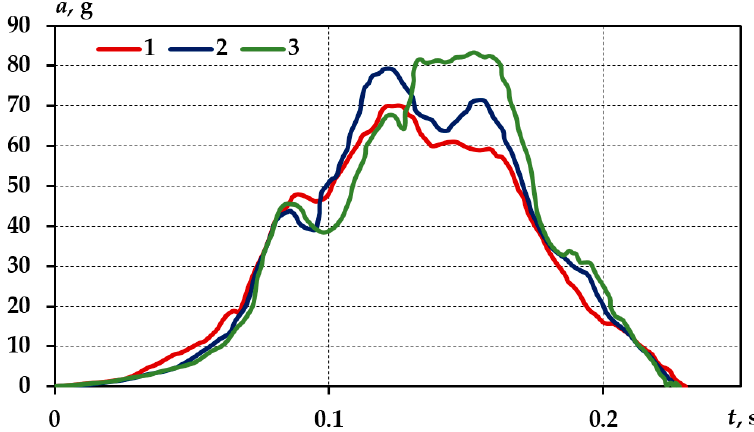
Figure 16. Overloads acting in the 3rd crumple zone at initial collision velocity 64 km/m; (1—original parameters of all the zones; 2—1st zone consisting of non-genuine parts; 3—1st zone consisting of non-genuine parts, 2nd zone stiffness lower than 30%).